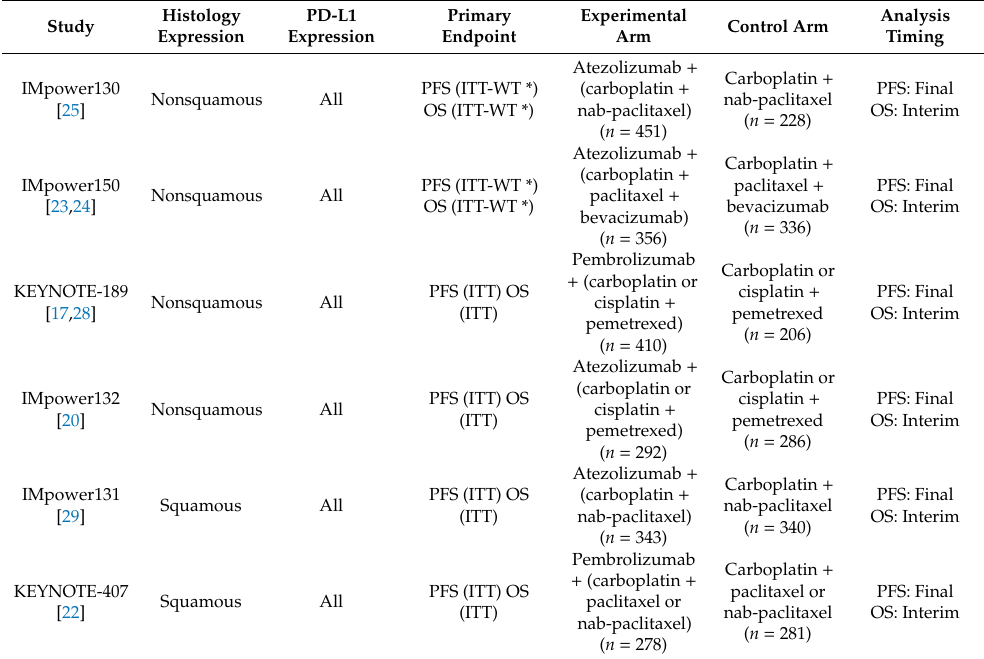
Figure 1. Flow chart of study selection (up to 1 January 2020). NSCLC, non-small-cell lung cancer; RCTs, randomized controlled trials. Table 1. Characteristics and main outcomes of the studies included in the